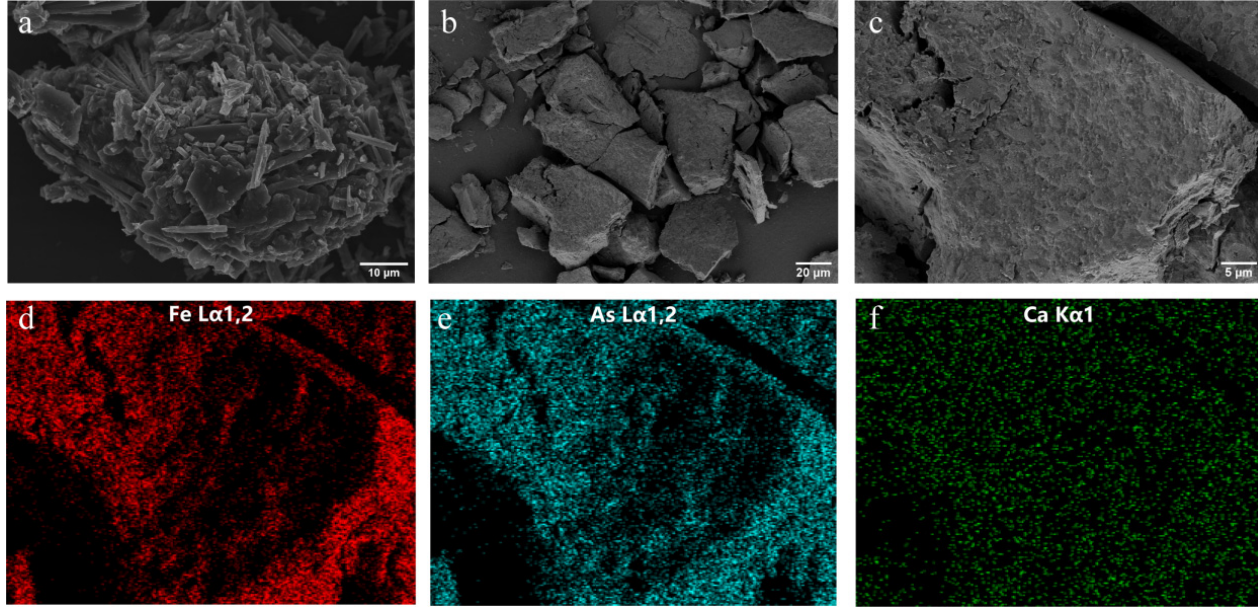
Figure 6. SEM morphology image of As-Fh ( a ) and As-Ca-Fh ( b ) after bioreaction; selected EDS mapping areas ( c ) and elemental distribution of Fe ( d ), As ( e ), and Ca ( f ) of As-Ca-Fh.